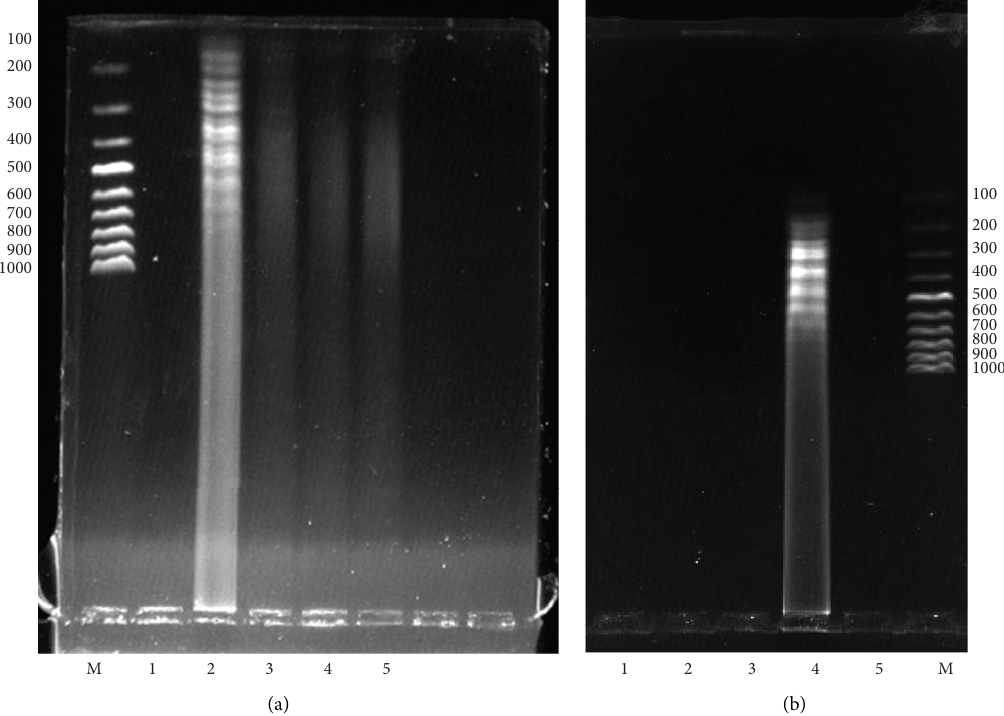
Figure 6: Optimization of optimum conditions for RT-LAMP. (a) Optimization of the amplifcation temperatures for the RT-LAMP assay M-100bp molecular ladder, 1 -NTC, 2 -65 ° C, 3 -60 ° C, 4 -55 ° C, and 5 -50 ° C for a duration of one hour. (b) Optimization of the incubation